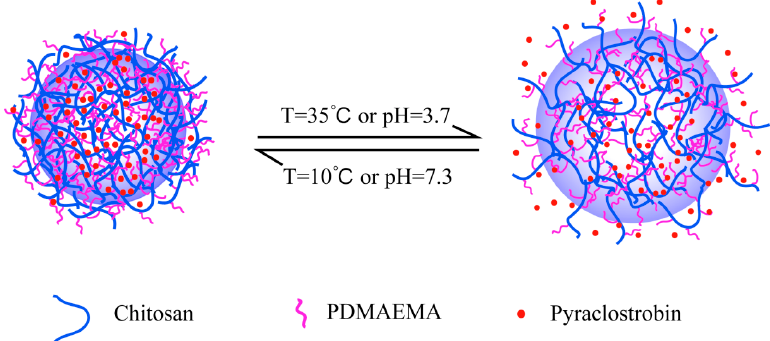
Figure 7. Schematic illustration of responsive release of pyraclostrobin from Pyr@CS- g -PDMAEMA microcapsule under different thermo and pH conditions.